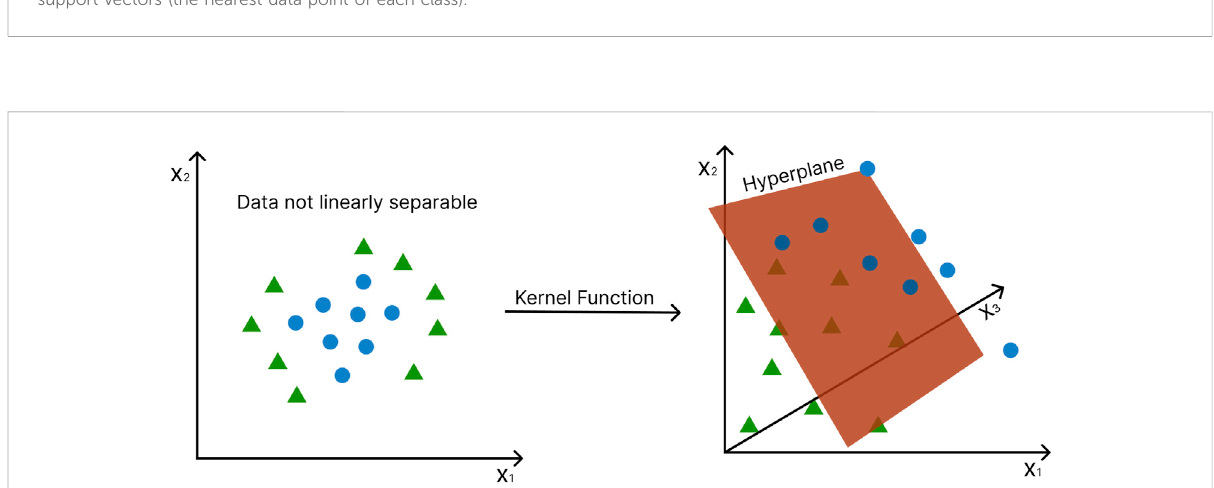
FIGURE 6 The “ kernel trick ” - non-linearly separable data points are mapped into a higher dimensional feature space in which they become linearly separable.Axesrepresentdifferentfeatures.Greentrianglesandbluecirclesrepresentdifferentconditions(e.g.,diseasevs.control).Thehyperplane, in this case, becomes a two-dimensional